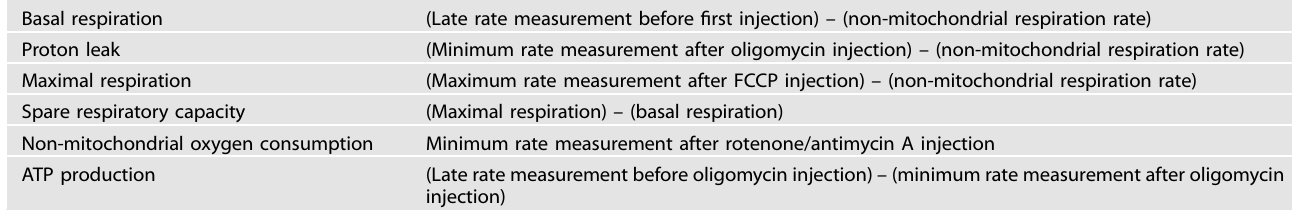
Table 1. Equations for calculations of mitochondrial activity. Basal